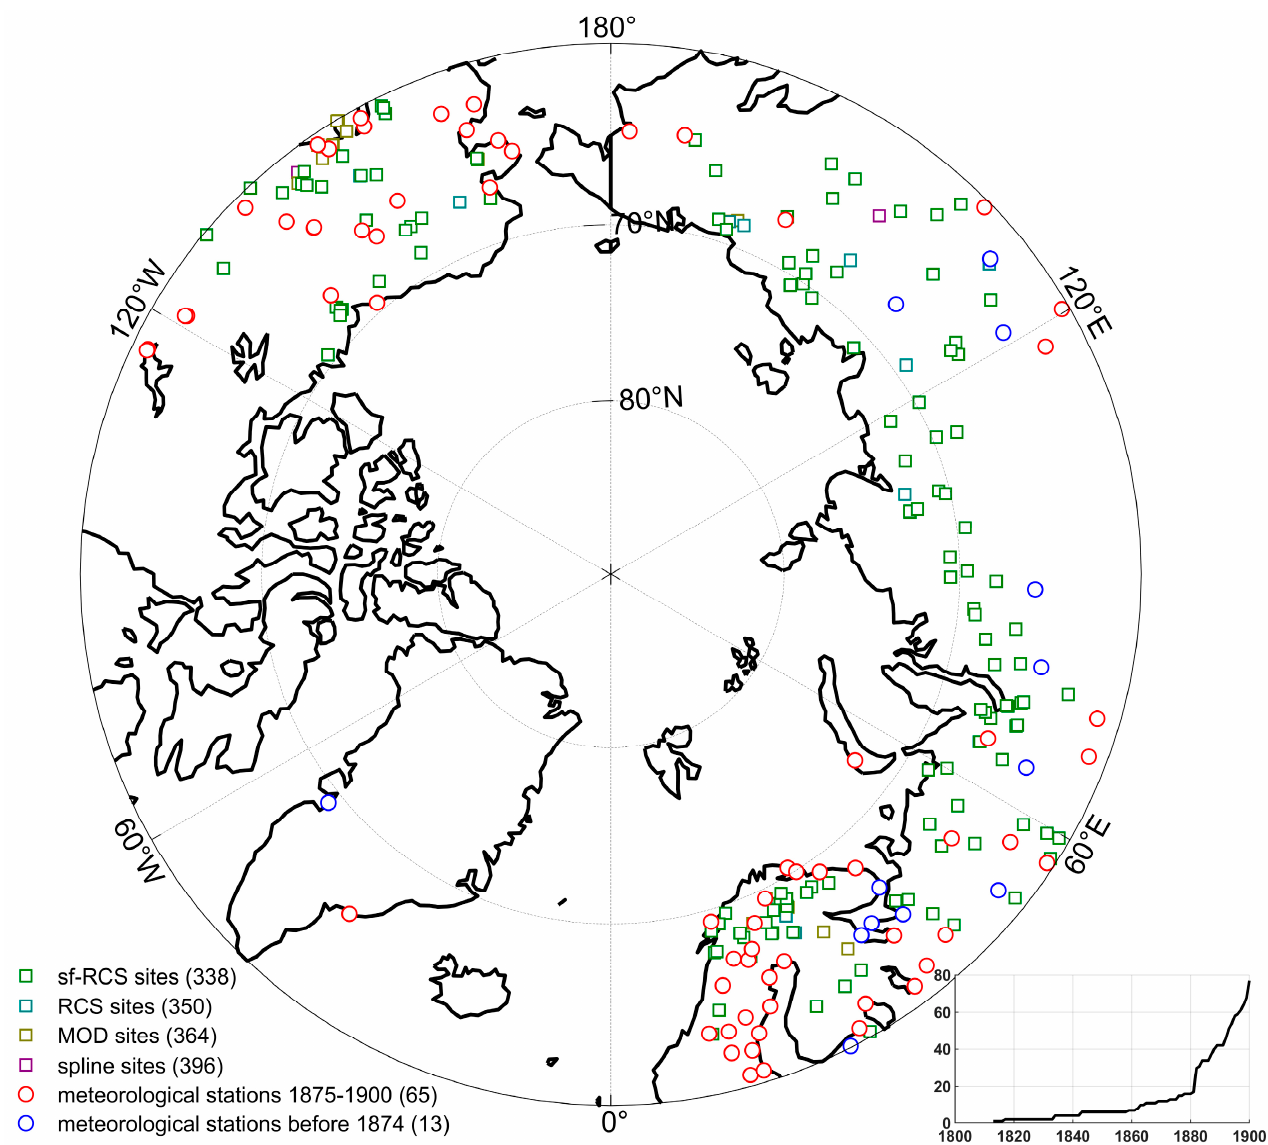
Figure 1. The green, blue, yellow, and purple squares show sites with tree-ring width and density records showing significant ( p < 0.05) correlations with the CRU summer Temp of the corresponding grid point with sf-RCS, RCS, MOD, and spline detrending methods, respectively. The red and blue circles indicate the meteorological stations with Temp between 1875 and 1900 and before 1874 in the Arctic, respectively. The insert at the right bottom shows the number of meteorological stations from 1800 to 1900 in the Arctic.